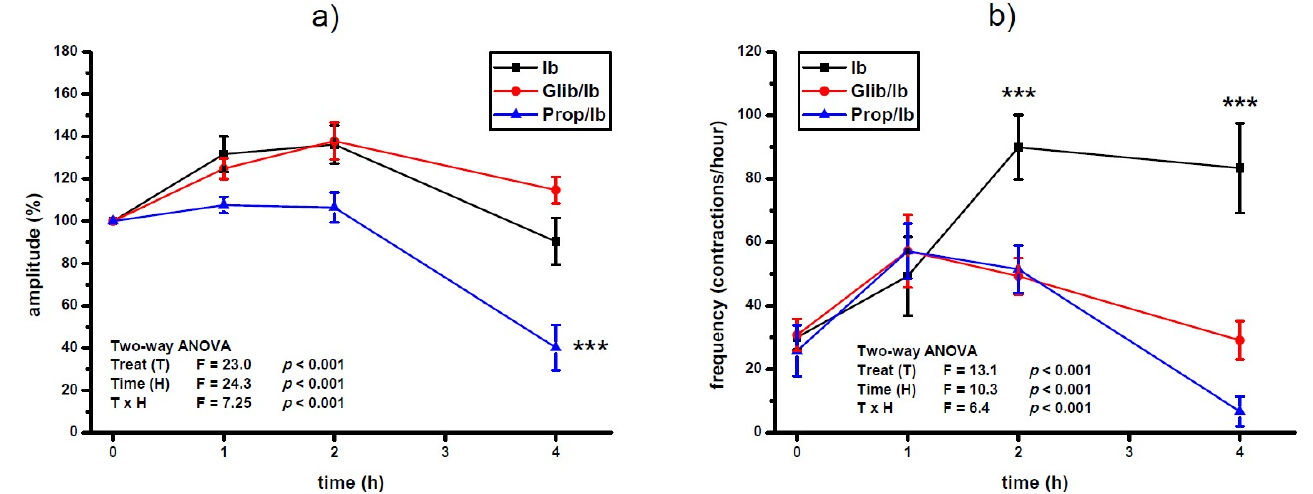
Figure 2. Amplitude ( a ) and frequency ( b ) of spontaneous uterine contractions treated with a single dose of ibogaine (28.8 µ mol/L) and pre-treated with either glibenclamide or propranolol. Results are expressed as the mean ± SEM ( n = 7).